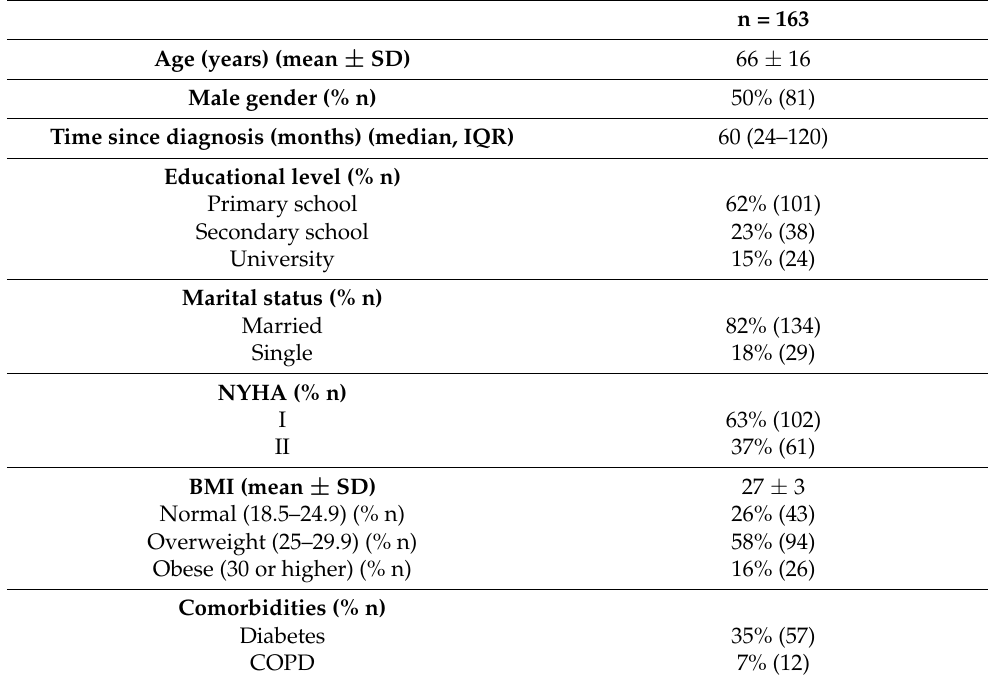
Table 1. Demographic and clinical characteristics of 163 patients with heart